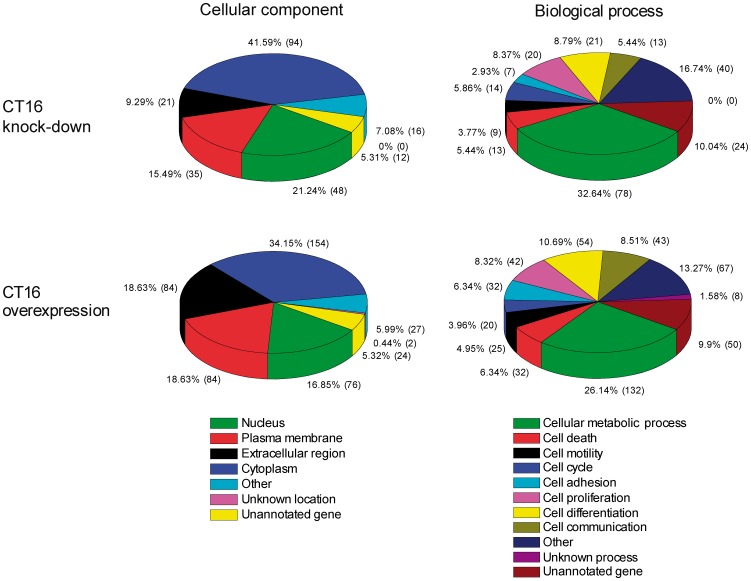
Classification of differentially expressed genes by selected cellular component and biological process gene ontology categories (GO slims).The differentially expressed genes from CT16 knockdown and overexpression experiments were analyzed separately. The number of genes annotated to the particular category is in parenthesis. The mapping to GO slim ontology was done with GoTermMapper (http://go.princeton.edu/cgi-bin/GOTermMapper).